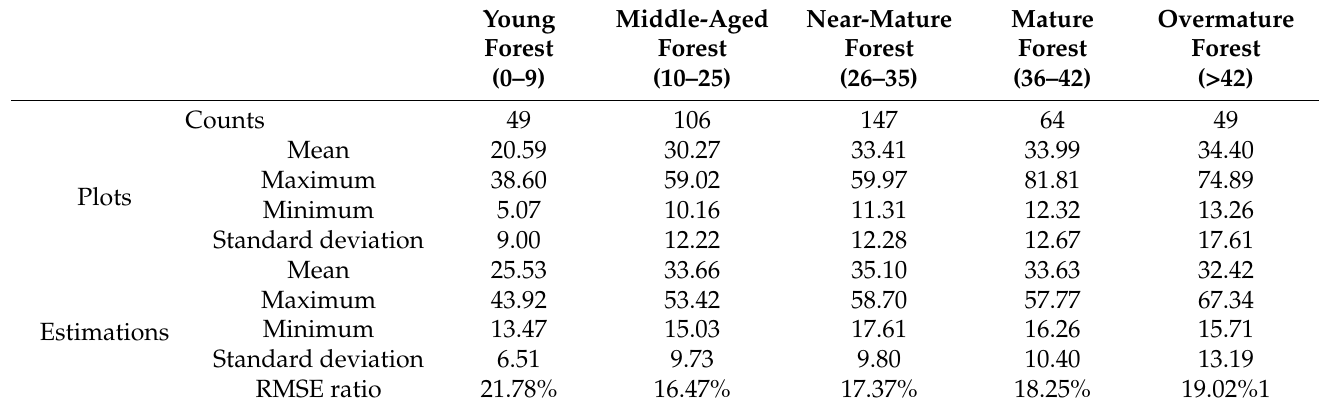
Table 3. Comparison of carbon density estimation with the field sample plots using the combination of random forest regression with allometric growth curve fitting.